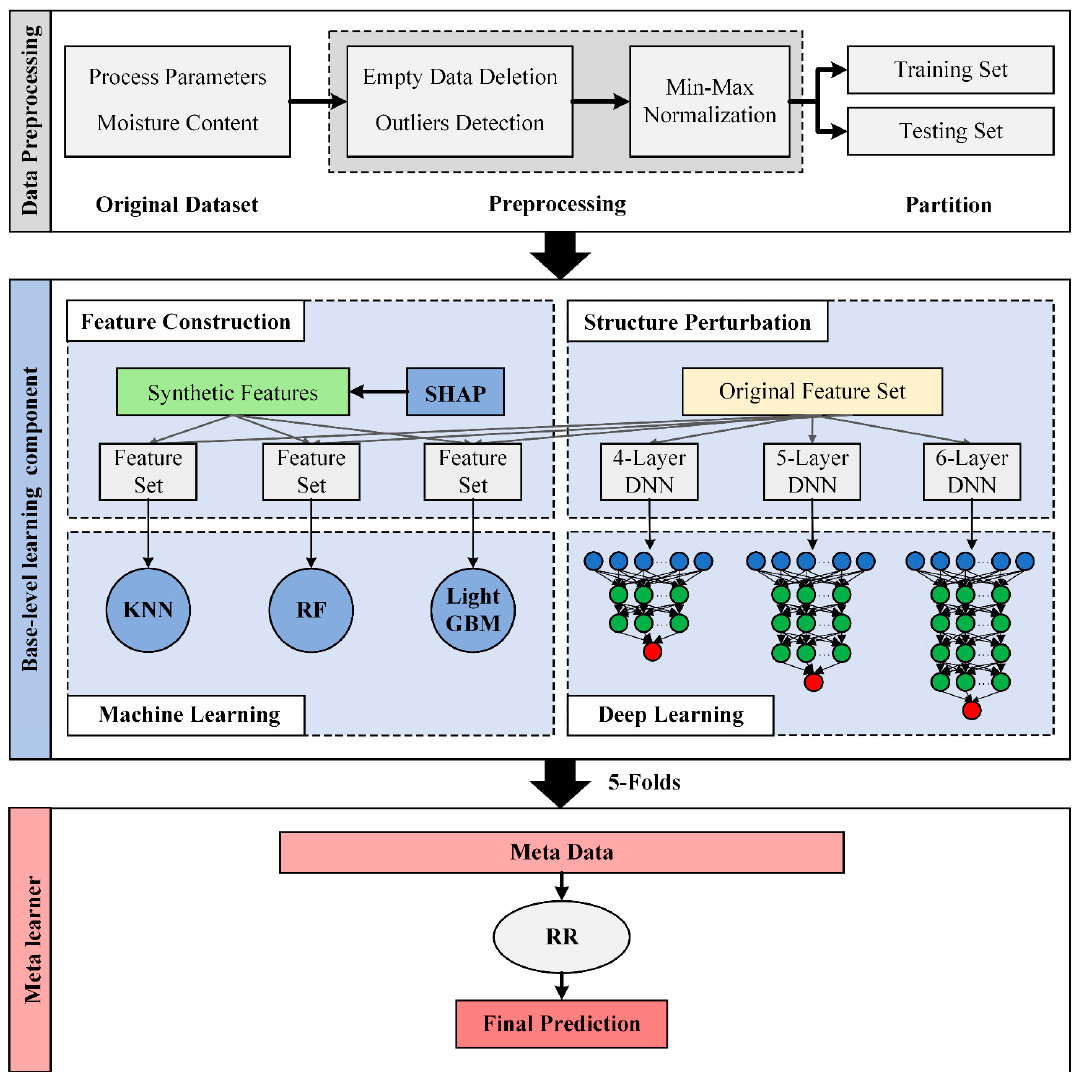
Figure 4. Framework of the proposed stacking ensemble